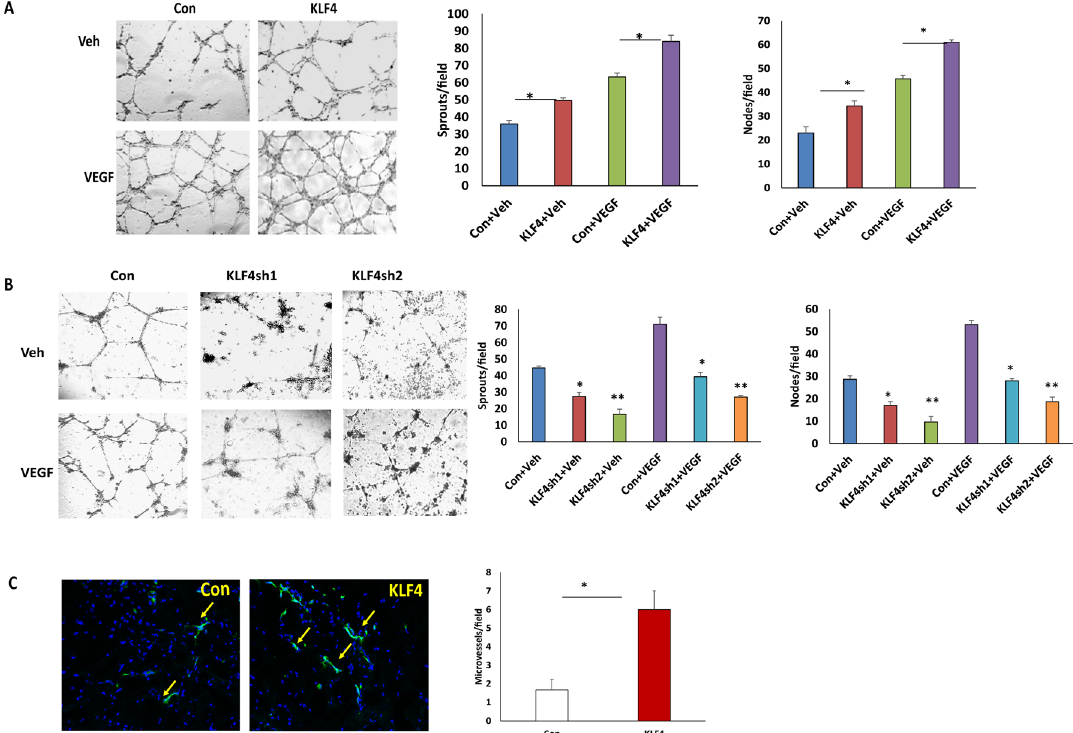
Fig 3. KLF4 promotes VEGF-induced tube formation and enhances angiogenesis in vivo. A.B. Tube formation assays were performed in KLF4 expressing and knockdown HRMECs, respectively. The angiogenic effect of KLF4 on VEGF induced tube formation was determined by counting nodes and sprouts of tube-like structures from at least three different fields of three independent experiments and normalized to vehicle treated control cells. Significance was compared between KLF4 expressing and control cells with or without VEGF treatment ( * p < 0.05, ** p < 0.01, *** p < 0.001). Images were presented from one representative experiment. C. Sections of plugs were stained using CD31 antibody and microvessels were counted from 4 sections of each plug and averaged from total 3 plugs. Significance of CD31 positive vessels were compared between sections of KLF4 expressing and control plugs ( * p <